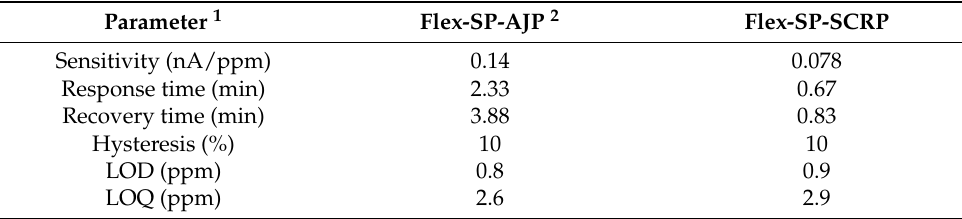
Figure 8. The amperometric ethylene sensor with the semi-planar topology on the flexible Kapton substrate: ( a ) Platinum pattern of the pseudoreference (RE) and counter (CE) electrode printed by the AJP technique, ( b ) Platinum pattern of the RE and CE fabricated by “lift-off” technology, ( c ) The ethylene sensor with the drop-cast SPE layer and AJP-printed gold WE, ( d ) The ethylene sensor with the screen printed SPE layer and gold WE. Table 3. Parameters of ethylene sensors on the flexible